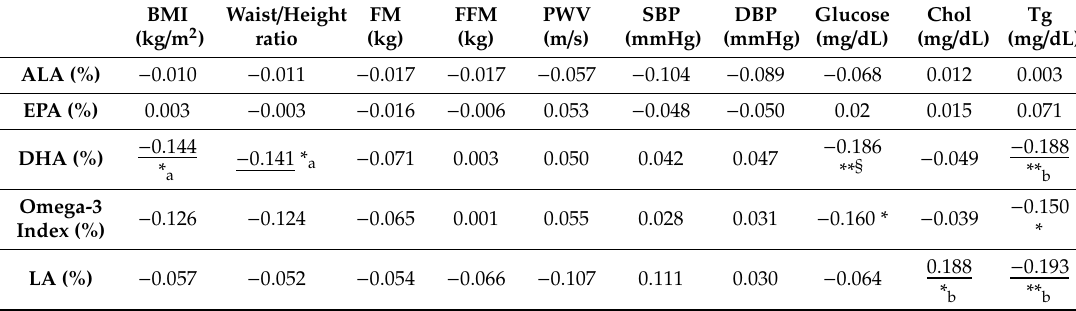
Table 2. Correlations of fatty acids and desaturases activities with anthropometric and clinical characteristics in the whole population (n: